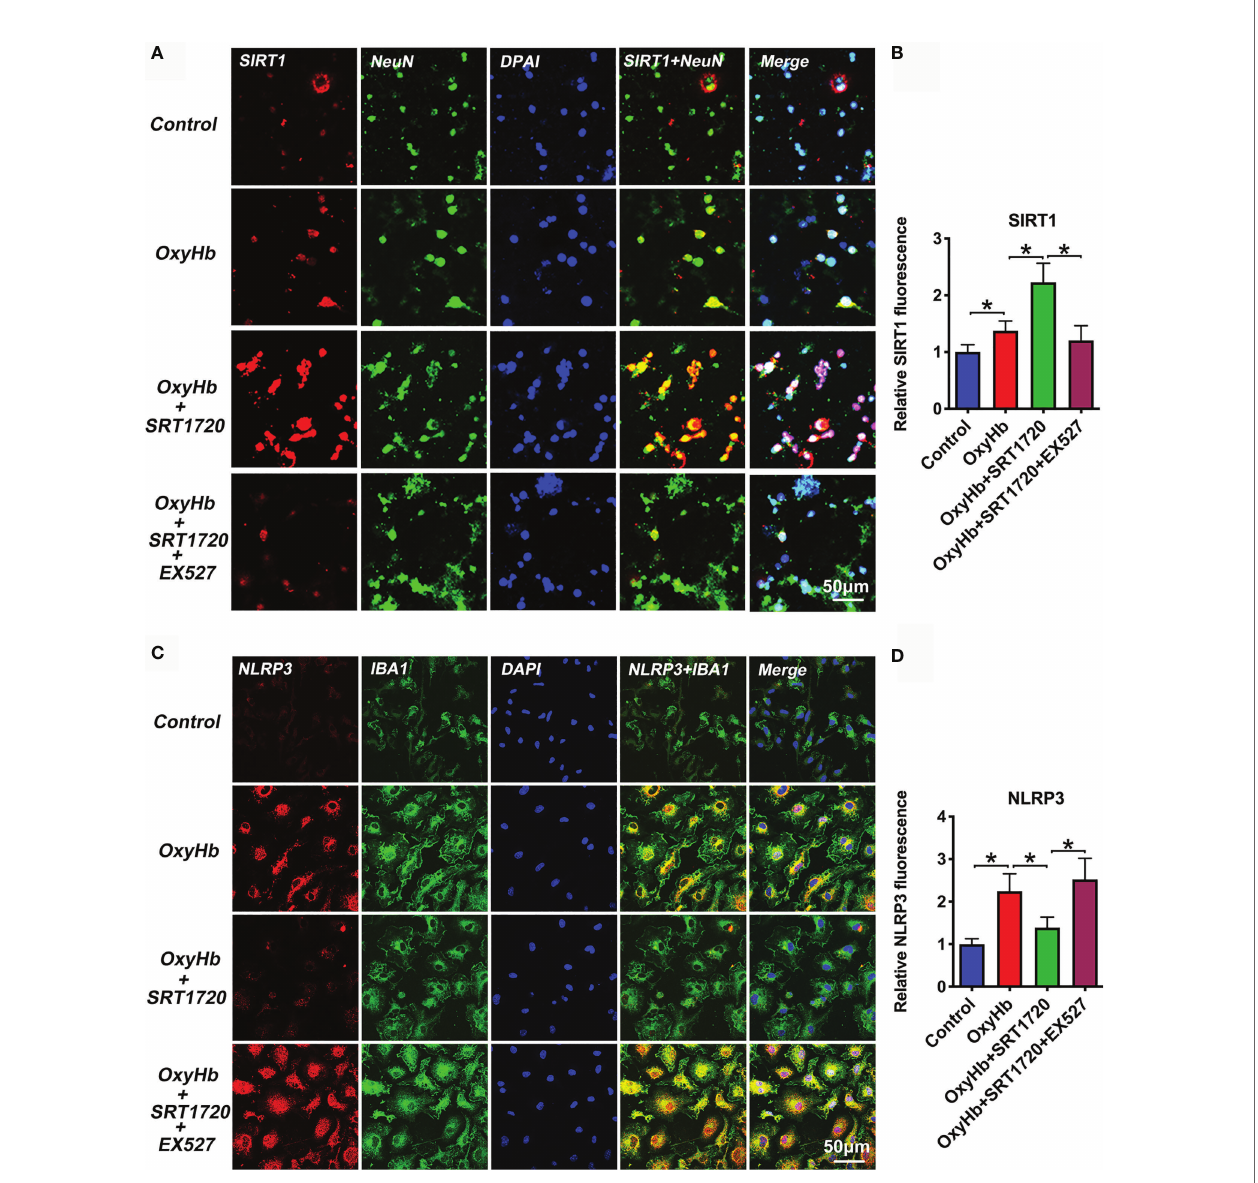
FIGURE 9 | Effects of SRT1720 treatment on SIRT1 and NLRP3 staining in vitro . Representative photomicrographs (A) and quanti fi cation (B) of SIRT1 staining in primary cortical neurons. Representative photomicrographs (C) and quanti fi cation (D) of NLRP3 staining in primary microglia. Bars represent the mean ± SD. * P <